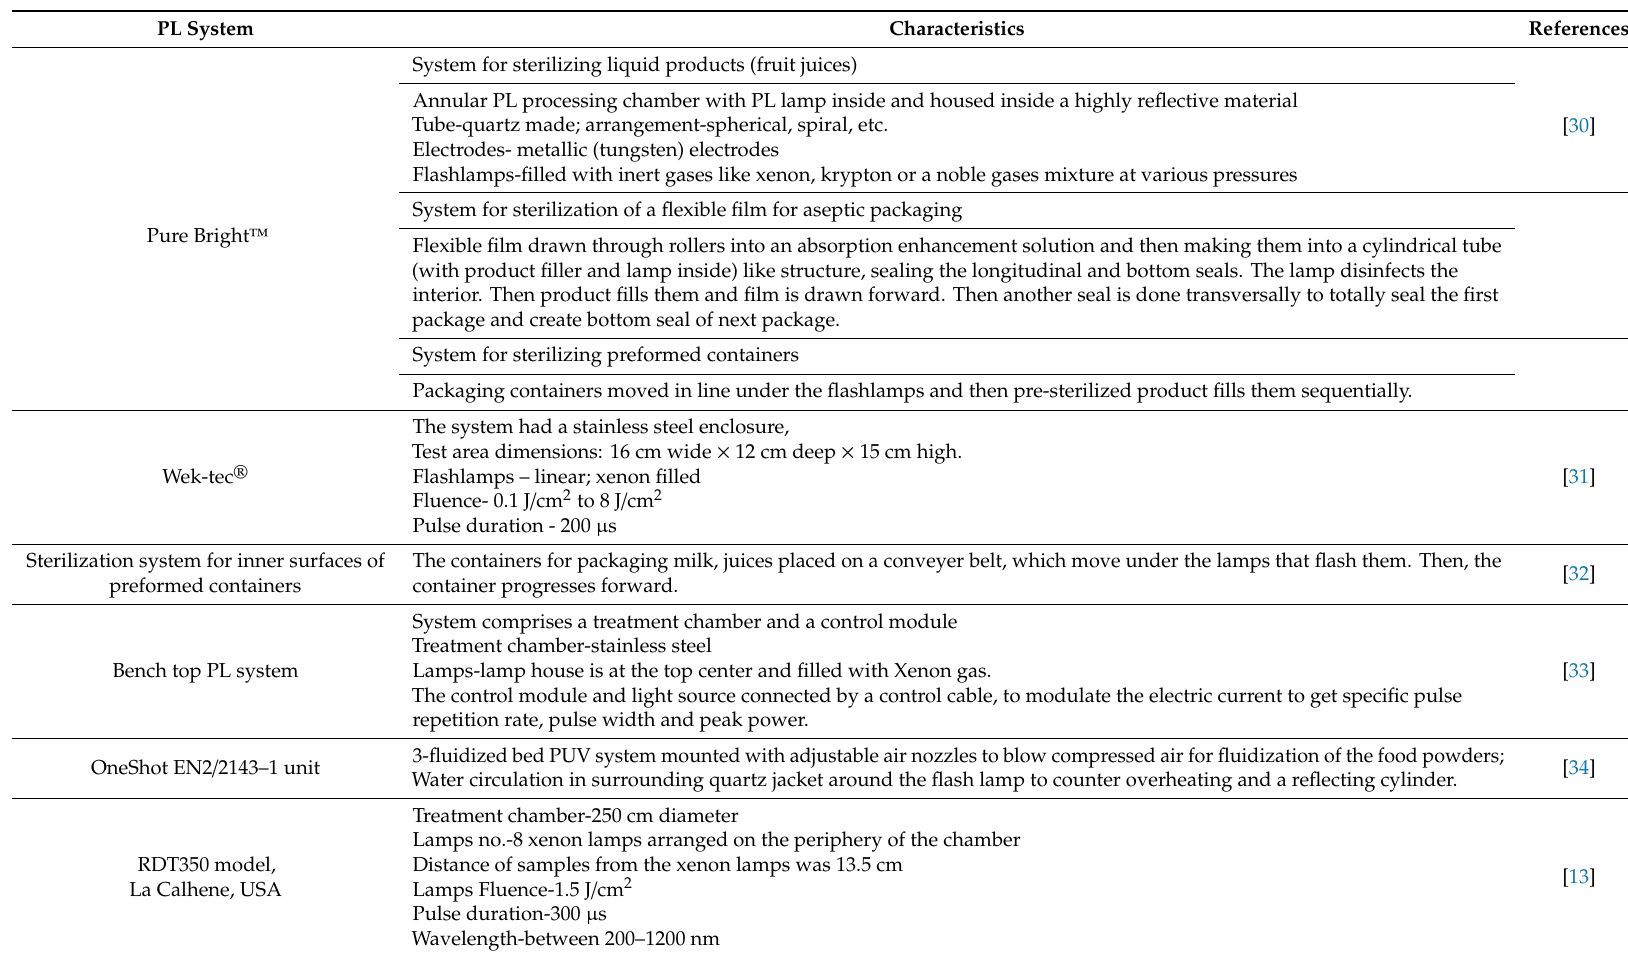
Table 2. PL systems for food